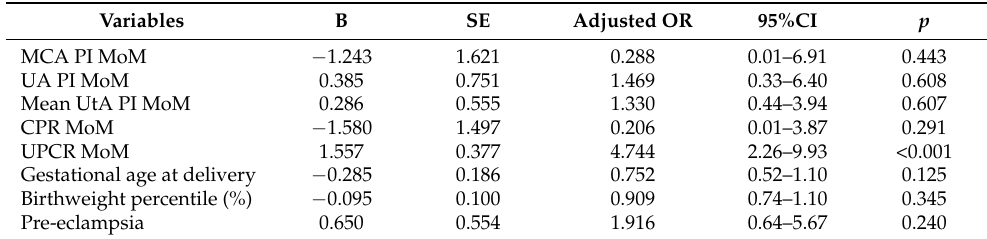
Table 3. Multivariate logistic regression analysis of the association of Doppler indices with adverse perinatal outcomes of late-onset FGR.